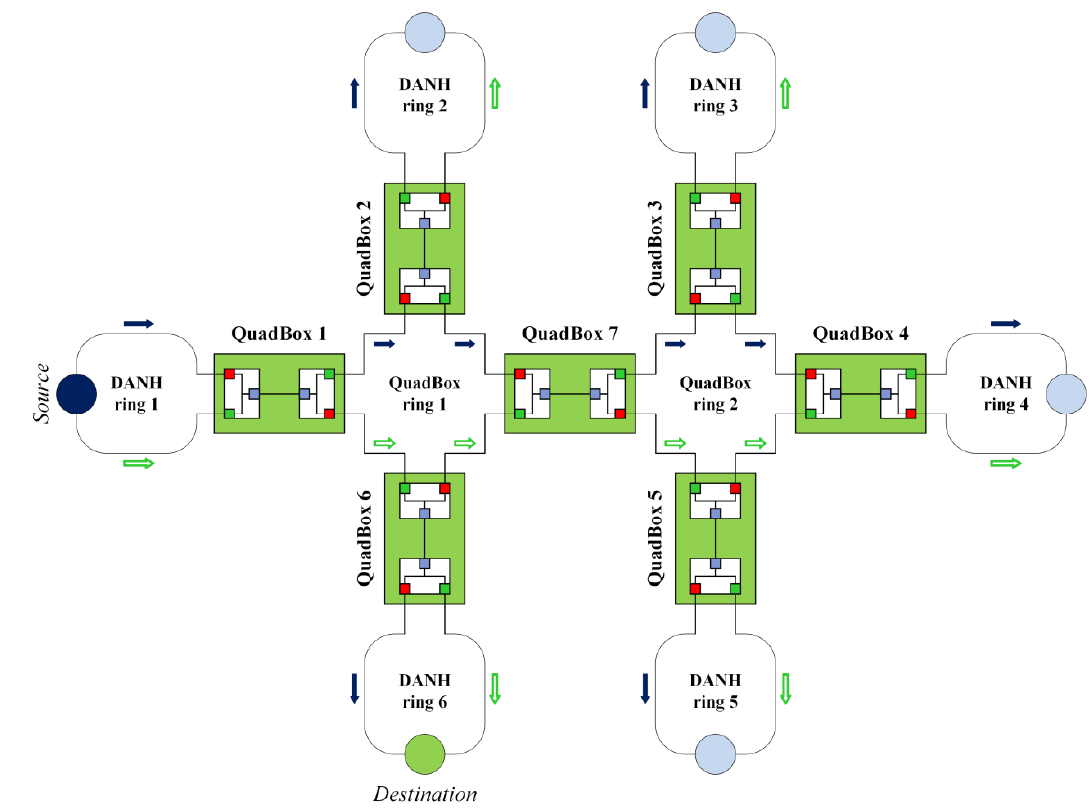
Figure 4. Removing duplicated and circulated frames under the